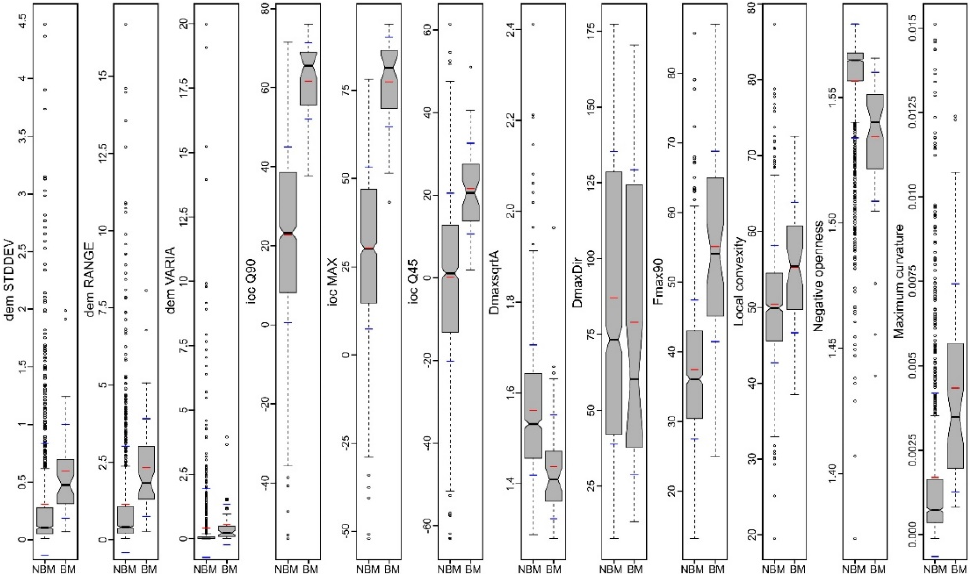
Figure 16. The descriptive statistics of the non-burial mound (NBM) and burial mound (BM) segments for the most important variables and for some variables that were not selected for fitting the RF model (local convexity, negative openness and maximum curvature). (a high-resolution version can be found at https://doi.org/10.6084/m9.figshare.11798691.v1)